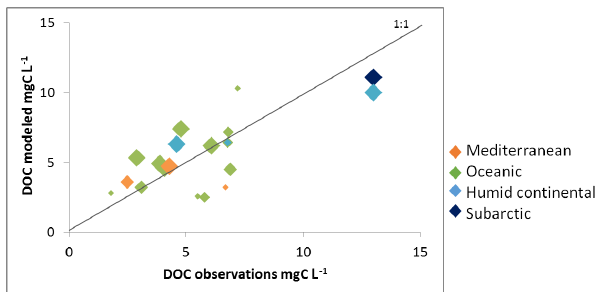
Figure 9. Modeled river DOC concentration against observed val- ues. The color code indicates the dominant climate zone for each catchment while the size of the diamond is proportional to the catch- ment area according to the following classes: < 10000, < 50000, < 100000 and > 100000km 2 . See Table S4 for further